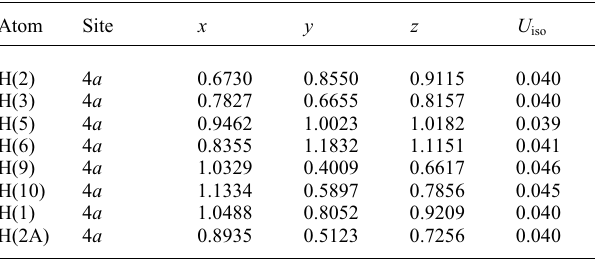
Table 3. Atomic coordinates and displacement parameters (in Å 2 )